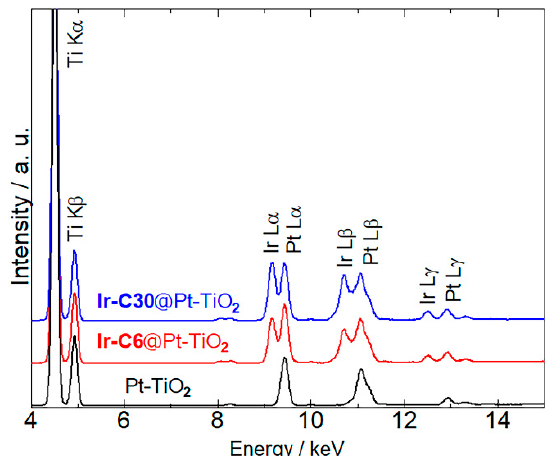
Figure 5. X-ray fluorescence (XRF) spectra of Pt-TiO 2 (black), Ir-C6 @Pt-TiO 2 (red), and Ir-C30@Pt- TiO 2 (blue) in the solid state at 293 K. The intensity of each spectrum was normalized based on the Ti K. β peak at 4.93 keV.